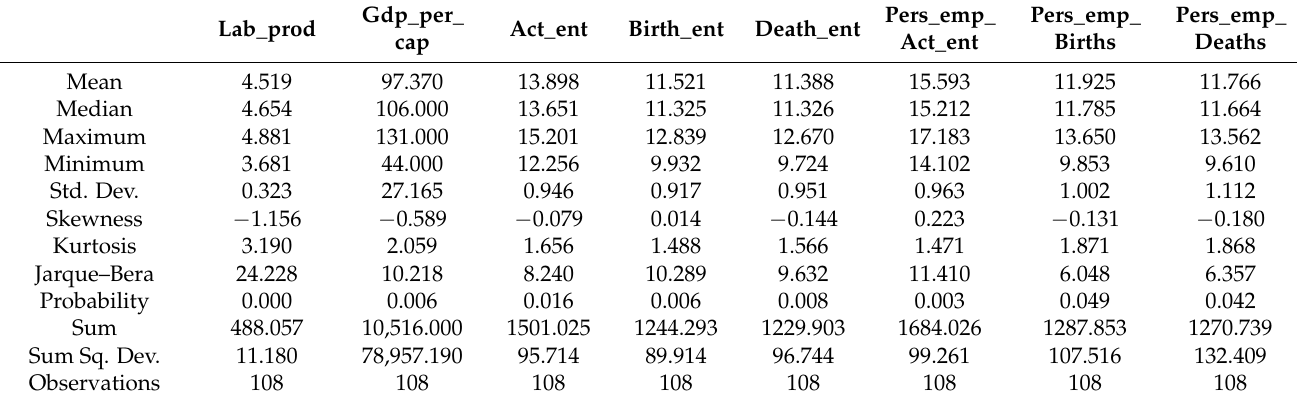
Table 4. The descriptive statistics of the